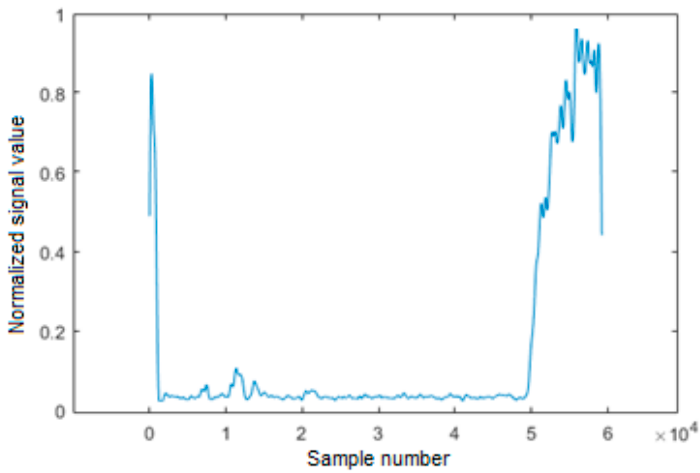
Figure 13. An example of the signal from envelope detector in squelch unit after smoothing and normalization.